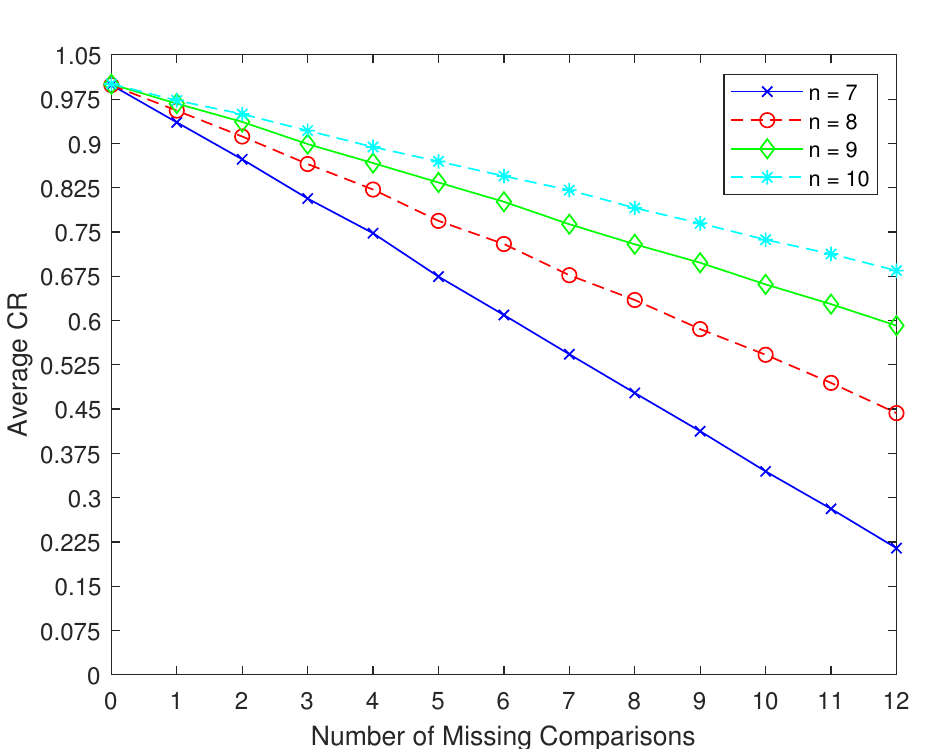
Figure 3. Average CR of 10,000 matrices vs. the number of missing comparisons k with respect to the matrix size n corresponding to Table